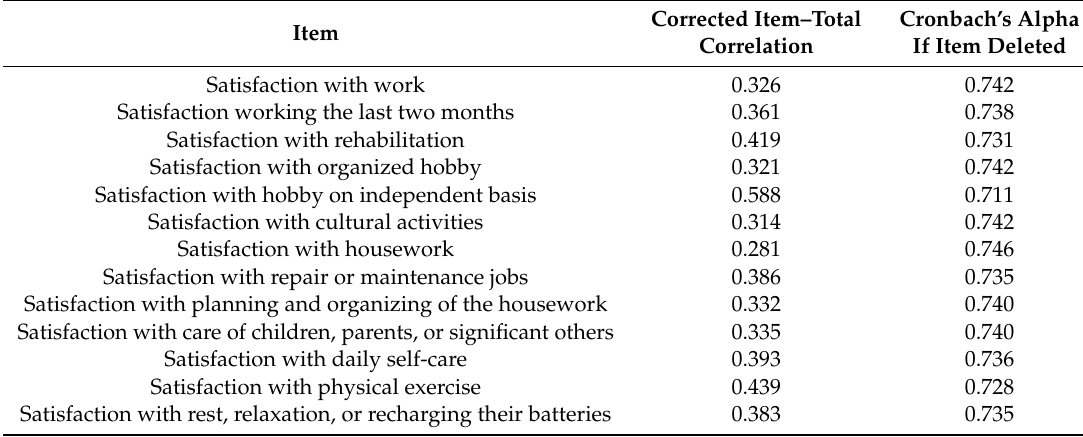
Table 3. Corrected Item–Total correlation and alpha value if item deleted.